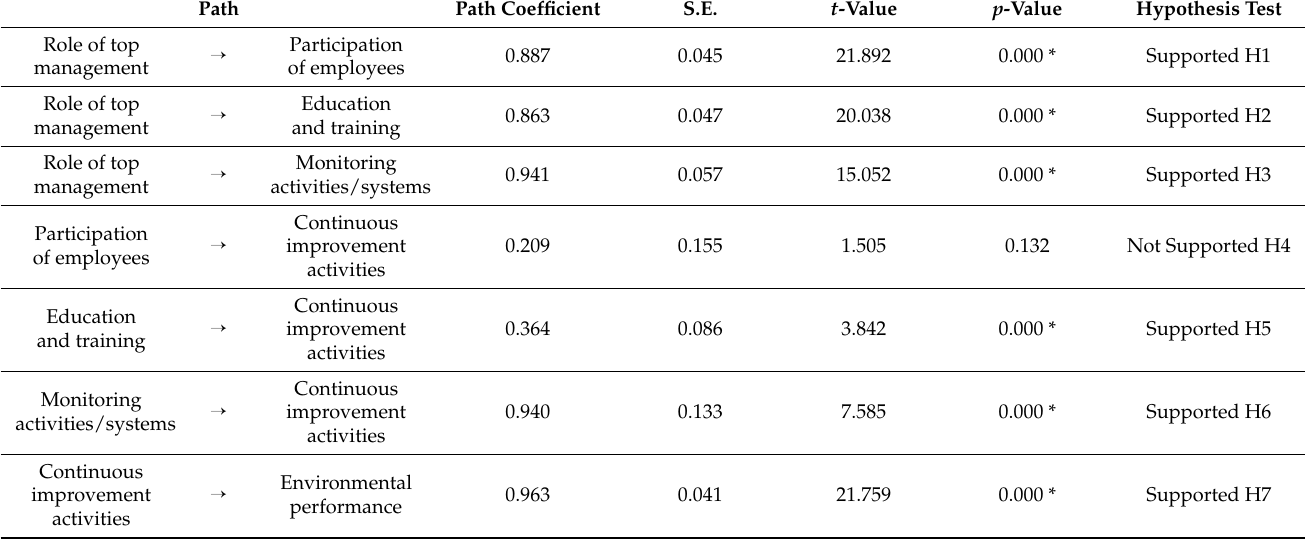
Table 8. Results of Hypotheses